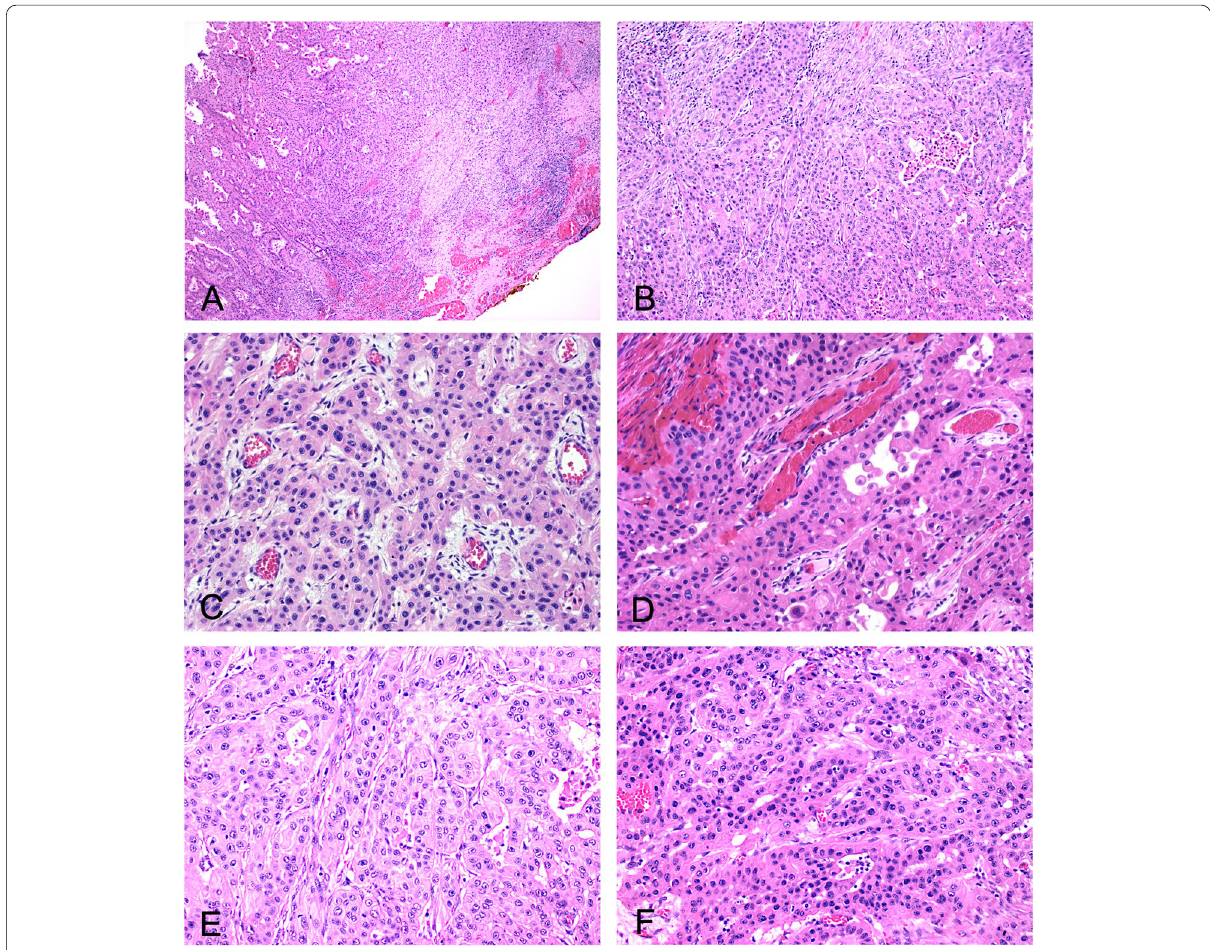
Fig. 1 Morphology on hematoxylin & eosin staining. A, B & C A solid-cystic infiltrative proliferation of oncocytes forming nests, cords, and trabeculae (H&E; 40X, 100X & 200X). D Tubulocystic area showing cysts lined by oncocytes and rare vacuolated cells (H&E; 200X). E Focus of